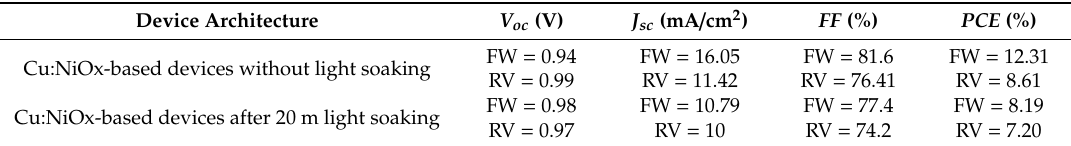
Table 2. PV parameters of Cu:NiOx-based devices before and after light